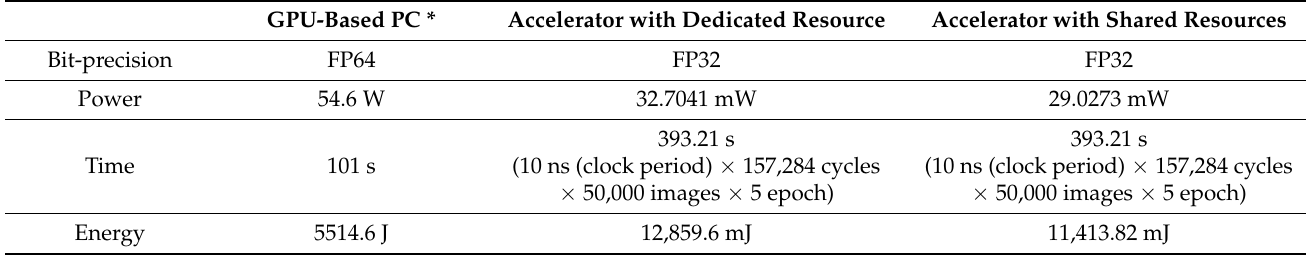
Table 5. Comparison in terms of energy consumption. FP: floating point.